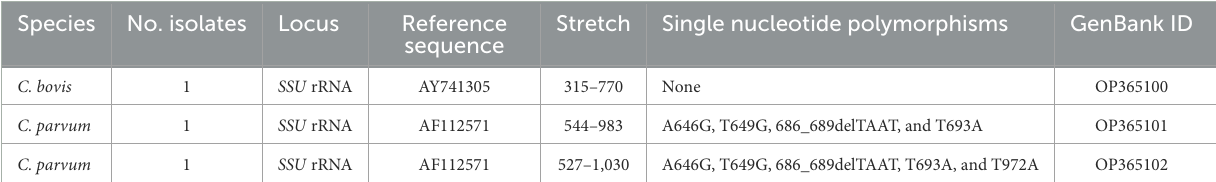
TABLE 3 Frequency and molecular diversity of Cryptosporidium spp. identified in camels in the present study.